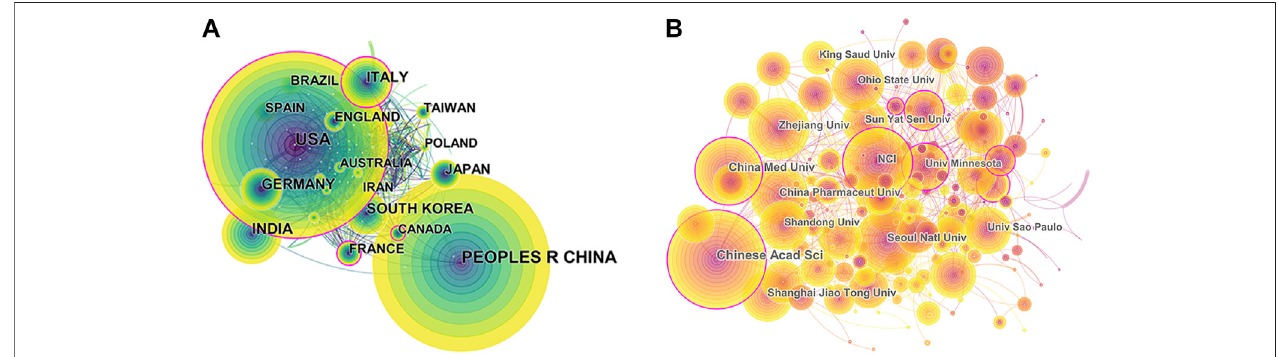
FIGURE 2 | CiteSpace network visualization map of country/regions and institutions related to natural products in cancer research. (A) Collaboration analysis of countries/regions. (B) Collaboration analysis of institutions. The nodes represent countries/regions or institutions, and lines between the nodes represent cooperation relationships. The larger the node size, the larger the number of publications. The nodes in the outermost area with purple rings indicate high centrality.